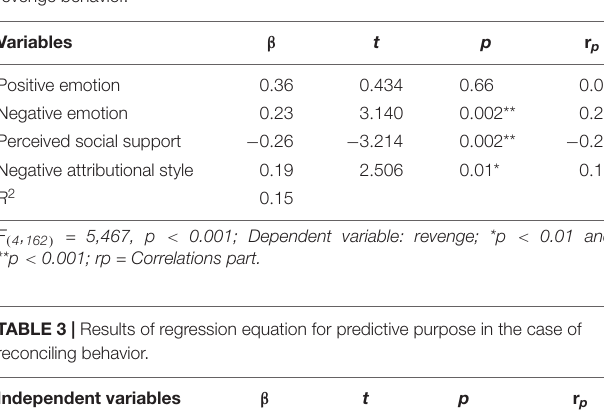
TABLE 2 | Results of regression equation for predictive purpose in the case of revenge behavior.